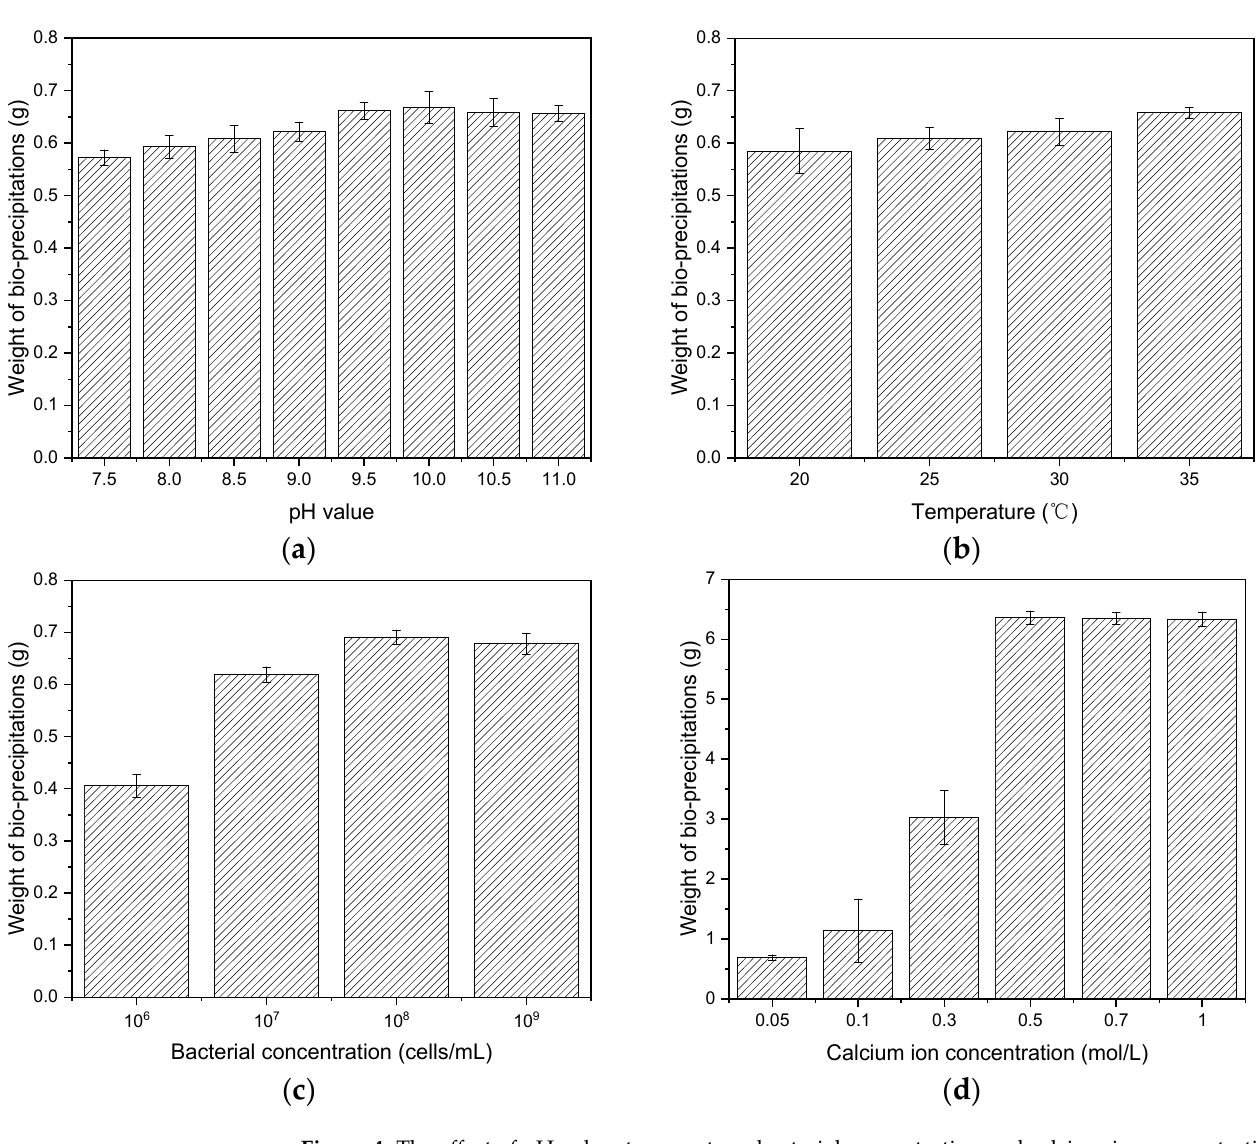
Figure 4. The effect of pH value, temperature, bacterial concentration and calcium ion concentration on the mineralization ability of bacteria. ( a ) pH value, ( b ) Temperature, ( c ) Bacterial concentration, ( d ) Calcium ion concentration.